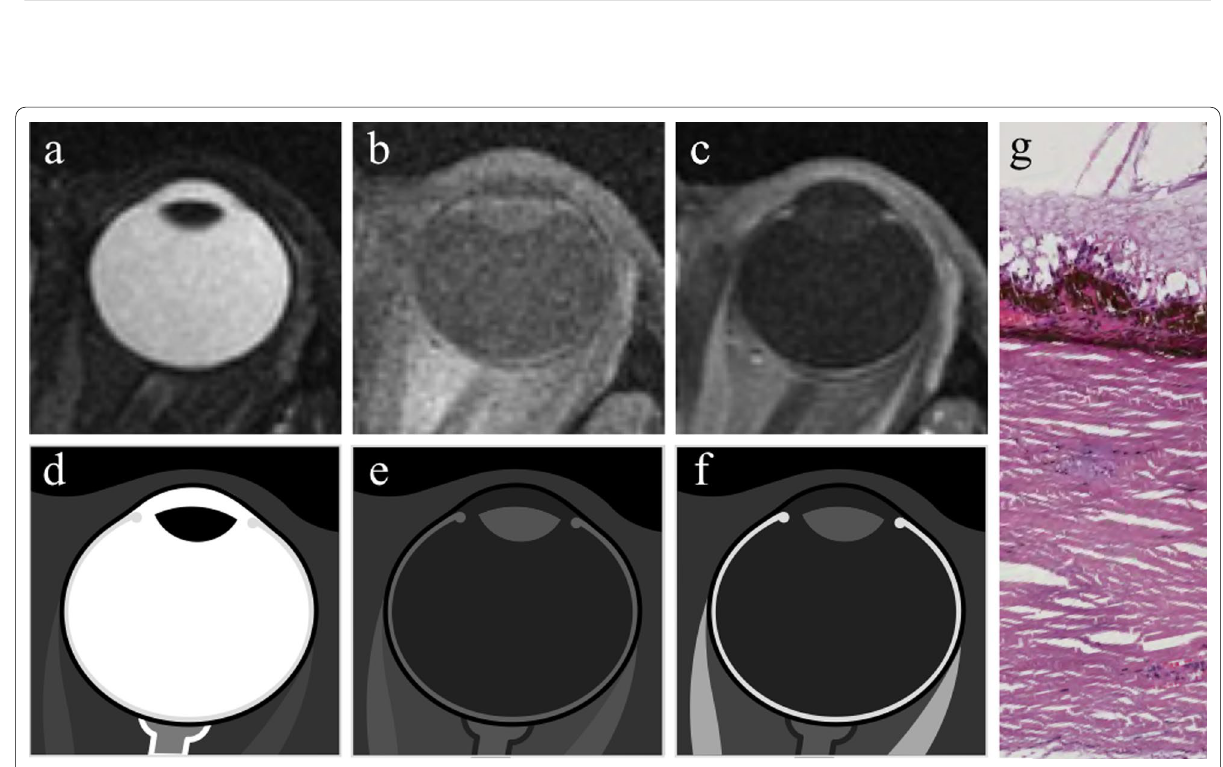
Fig. 6 MR anatomy of the eye. Axial ( a ) T2-weighted turbo spin-echo STIR, ( b ) fat-suppressed T1-weighted, ( c ) contrast-enhanced fat-suppressed T1-weighted images. d–f Corresponding schematic drawings. ( g ) Corresponding histological detail illustrating the three-layered wall of the globe: (from outer to inner) sclera, choroid and retina (H&E, original magnification ×